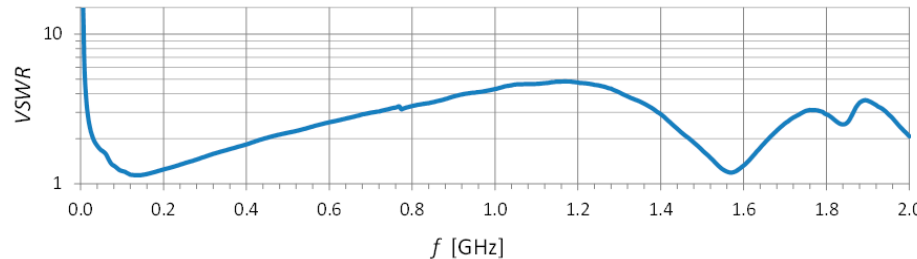
Figure 2. VSWR coefficient depending on the frequency of the signal. For transmitting–receiving antennas in semi-professional systems, it is assumed that the VSWR value should not be higher than 2 ( RL = 9.5 dB), which means that 11.1% of the power will be reflected from the antenna input (the signal will decrease by 0.5 dB). In practice, for receiving antennas used to monitor the electromagnetic spectrum, the acceptable value is VSWR = 3 ( RL = 6 dB), i.e., it is allowed that 25% of the power will be reflected from the input, and the signal attenuation will be equal to 1.25 dB. It can be assumed that signal attenuation of 3 dB is acceptable in the case of PD detection, especially if an amplifier is used to increase the power level of the received signals.